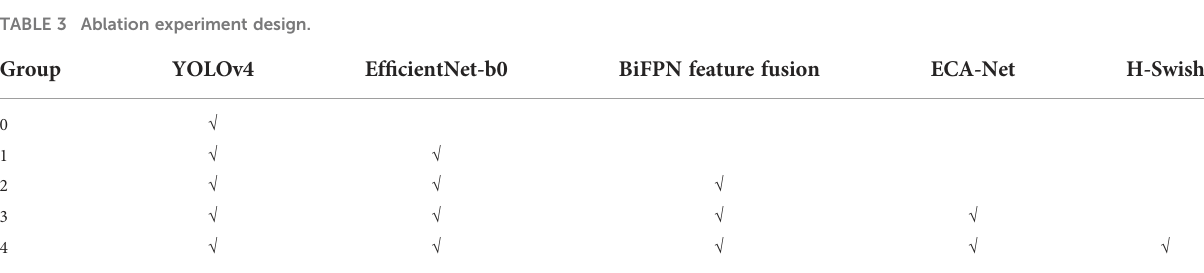
TABLE 3 Ablation experiment design.